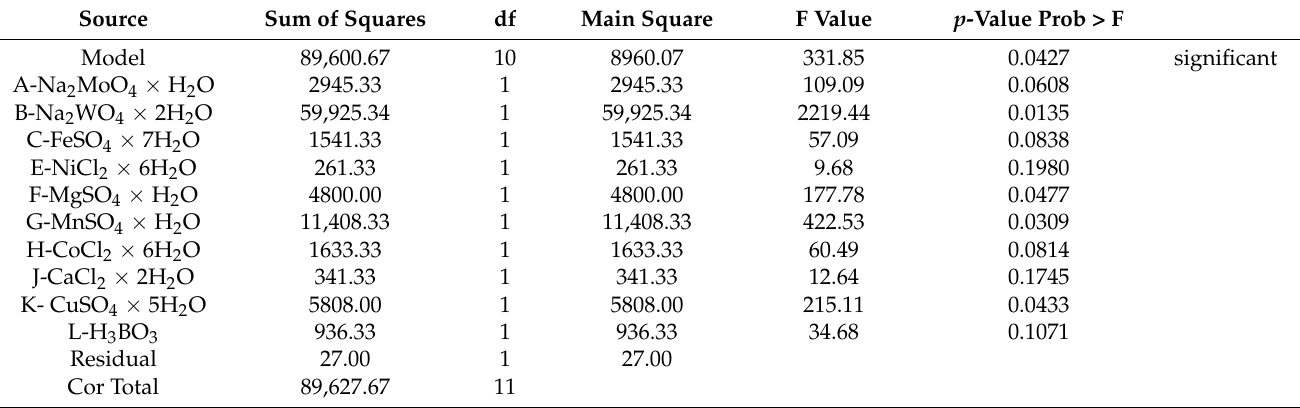
Table 3. ANOVA analysis report by Plackett-Burman in trace element optimization with Clostridium ljungdahlii